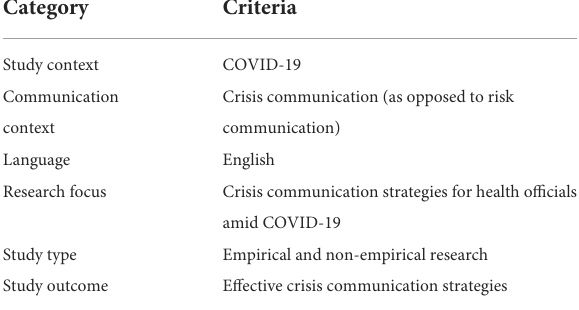
TABLE 1 Study inclusion